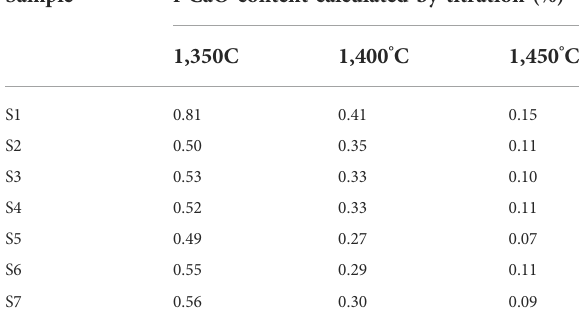
TABLE 4 Burnability test results for the cement raw meal under different preparation